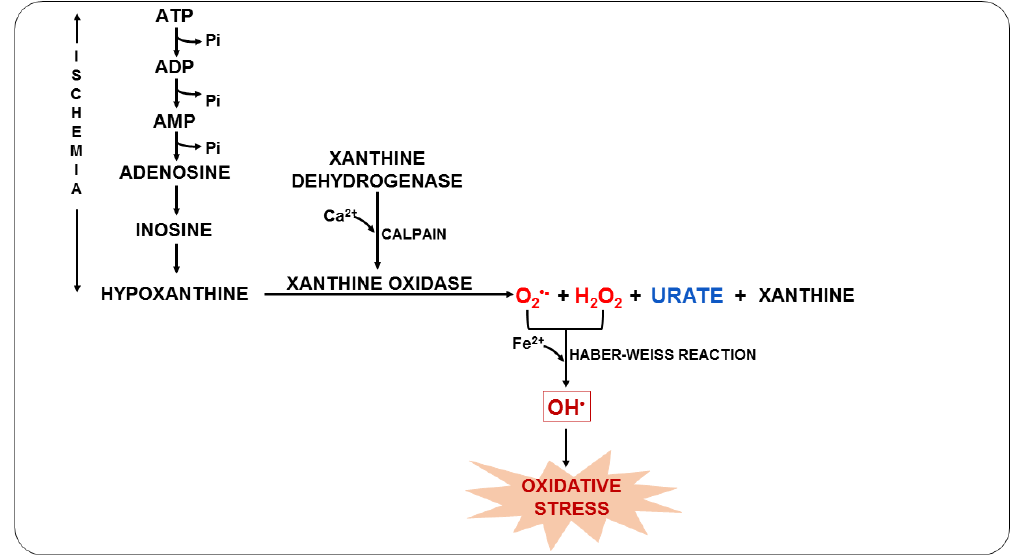
Figure 3. Oxidative stress due to ischemia-reperfusion syndrome during malaria.